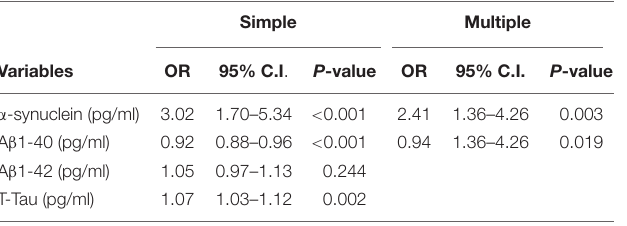
TABLE 3 | Binary logistic regression models for cognitive impairment in Parkinson’s disease patients. Simple Multiple